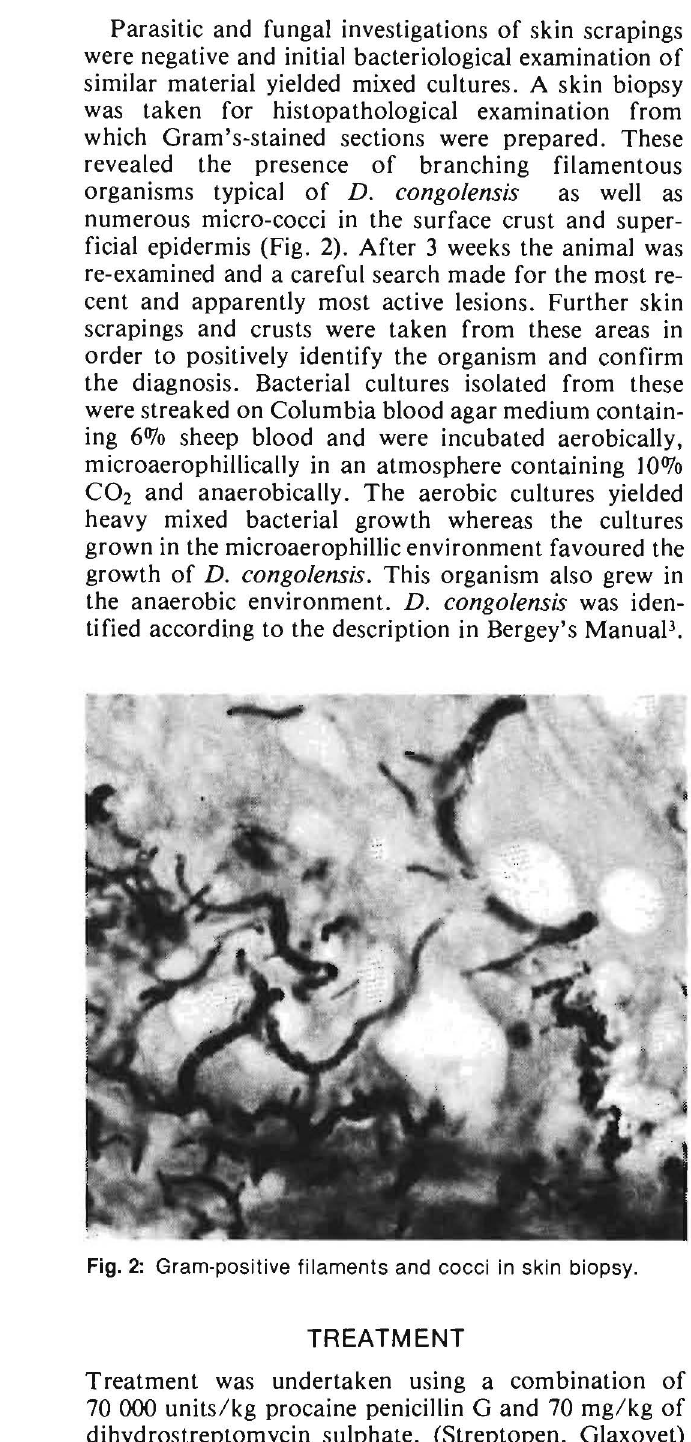
Fig. 2: Gram·positive filaments and cocci in skin